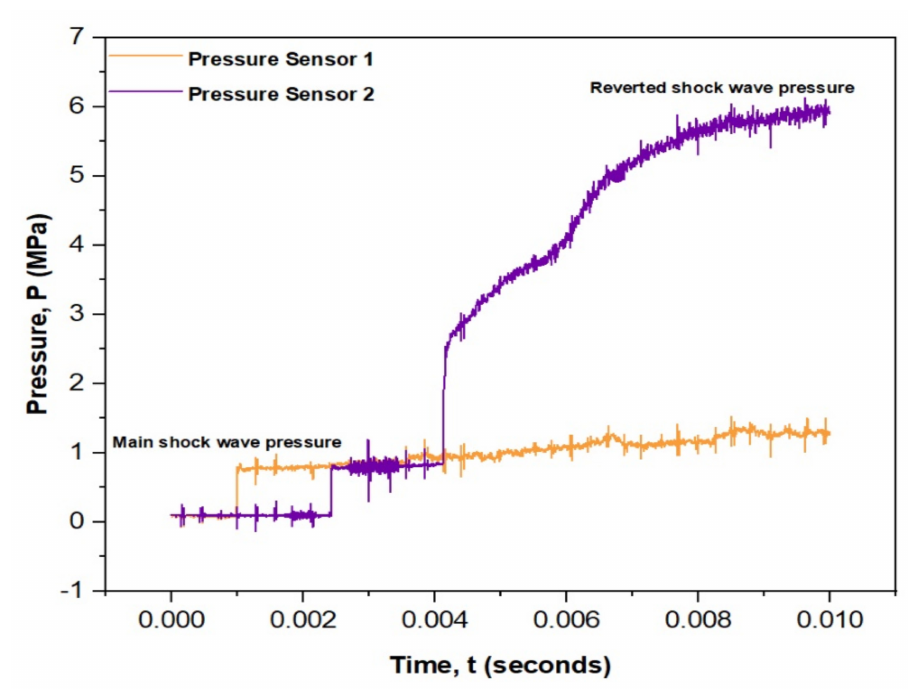
Figure 4. Shock wave pressure measured using the data acquisition